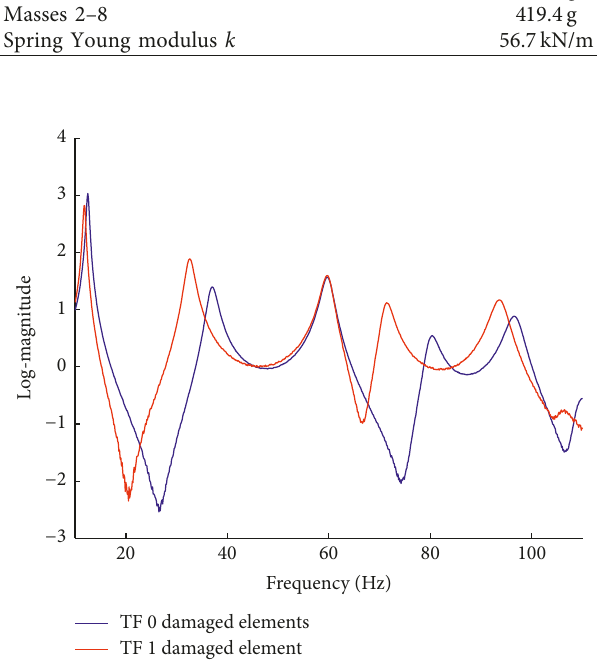
Figure 7: 8-DOF mass-spring system at Los Alamos National Laboratory. Table 2: Mass and strength values of the experimental setup. Mass 1